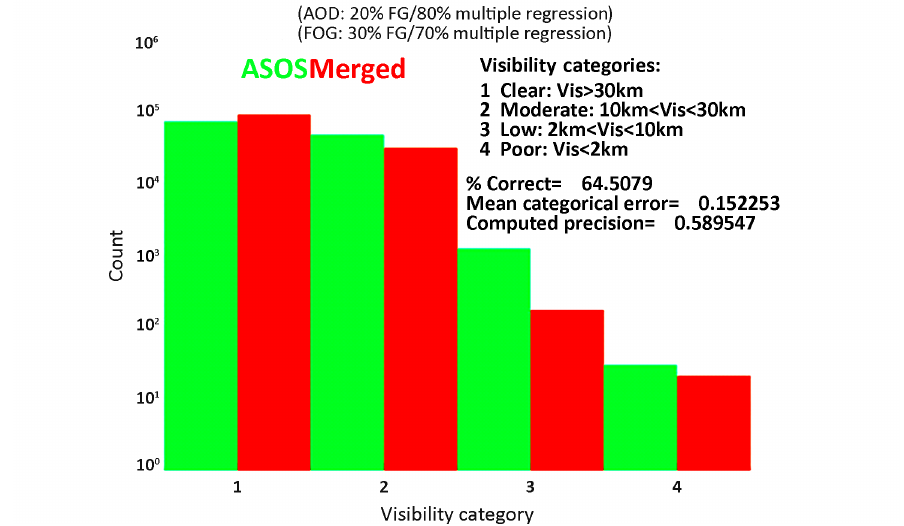
Figure 1. Categorical histograms of the coincident ASOS and ABI merged visibilities for January 2010 through December 2013. LCLD denotes low cloud and SDQF denotes standard deviation quality flag.